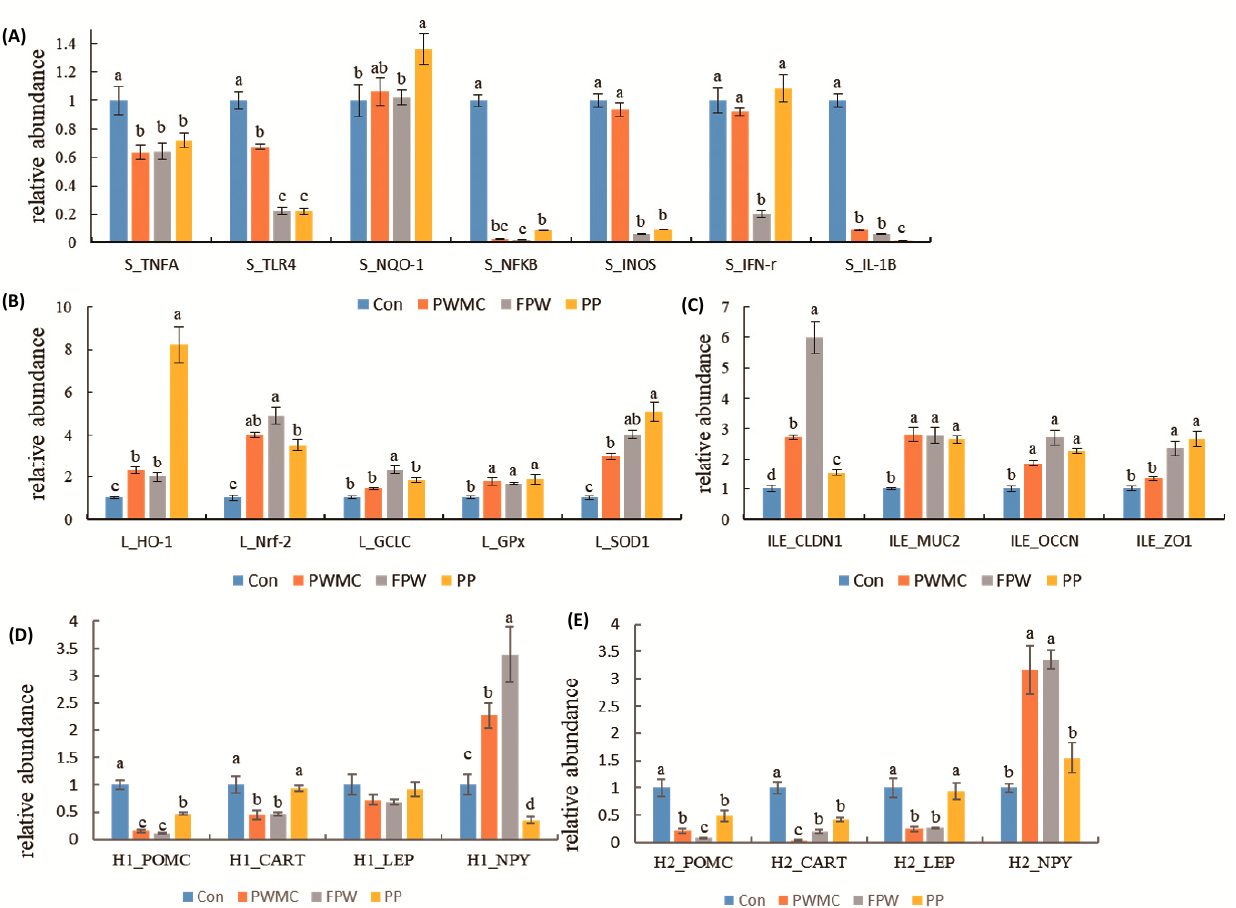
Figure 4. Relative abundance of mRNA expression in 35–day–old broilers given a corn–soybean basal diet (Con), Pen – nisetum purpureum Schum No. 2 waste mushroom compost (PWMC), Saccharomyces cerevisiae fermented PWMC (FPW), and Pennisetum purpureum Schum No. 2 (PP). ( A ) Inflammatory-related mRNA expression in broilers’ spleen; ( B ) Antiox–idant-related mRNA expression in broilers’ livers; ( C ) Gut barrier-related mRNA expression in broilers’ ileum; ( D , E ) Ap–petite-related mRNA expression in broilers’ hypothalamus before (H1, D ) and after fasting (H2, E ). Results are means of six samples obtained from the individual birds from the control and experimental groups. a–c Means within the same rows with distinct superscript letters are significantly different ( p < 0.05).